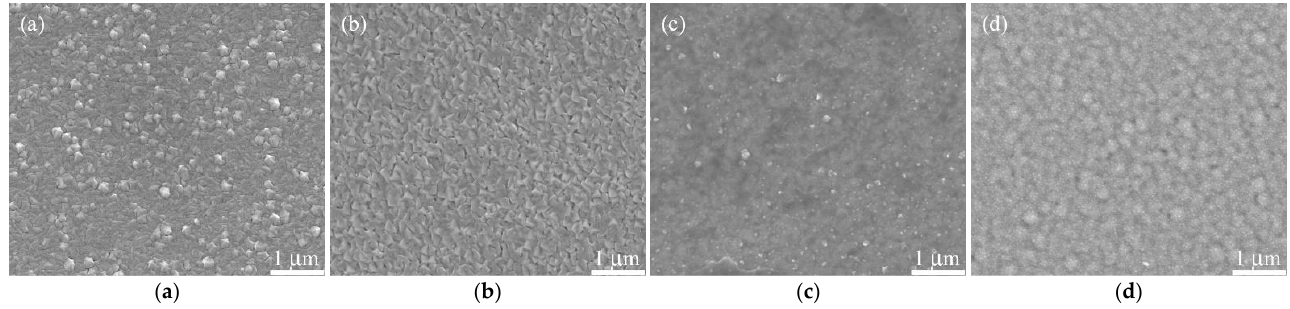
Figure 2. SEM surface images of the Cr-Ag films with glass substrate: ( a ) S0, ( b ) S15.0, ( c ) S27.7, ( d ) S39.2.